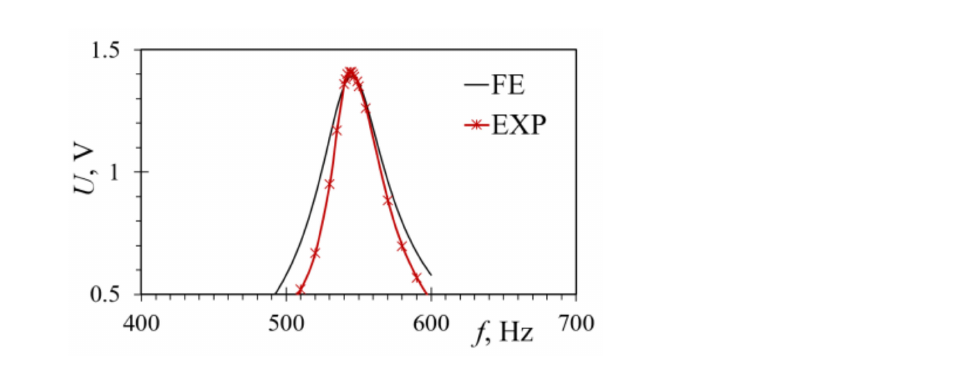
Figure 15. Comparison of experimental and FE voltage output values of a harmonically excited rectangular PEH device.